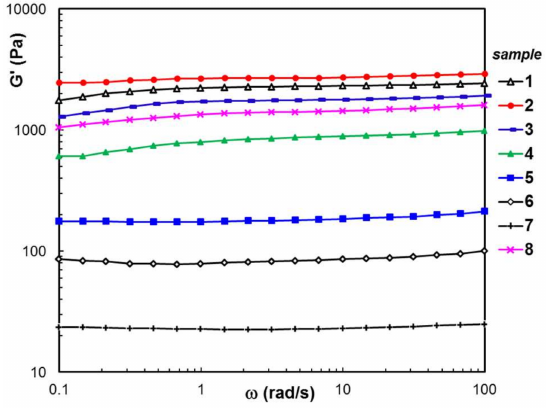
Figure 5. The G’— ω dependences for samples 1–8 (37 ◦ C, γ =